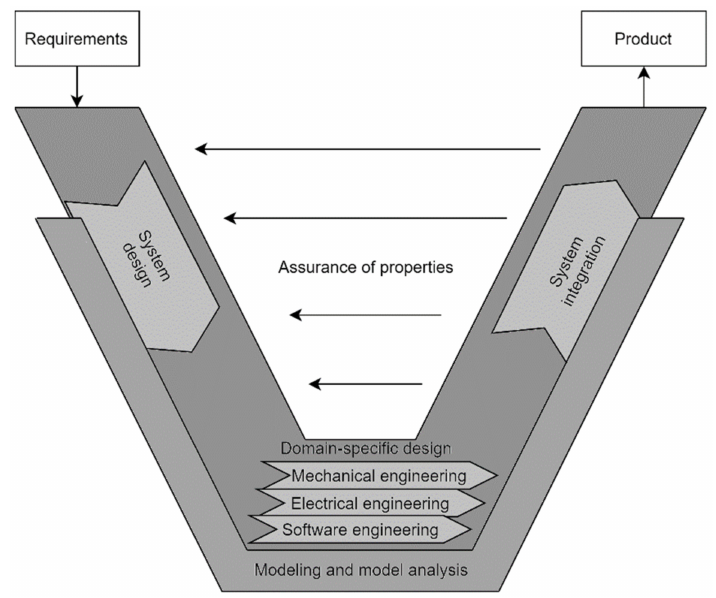
Figure 1. V-Cycle defined in VDI 2206.